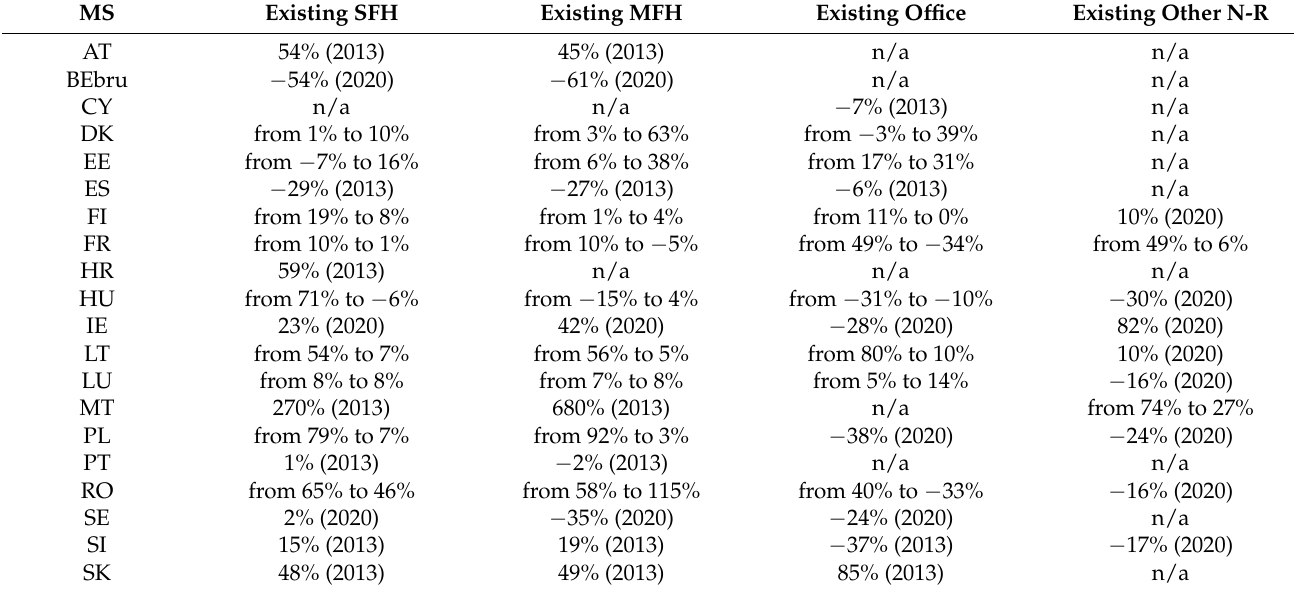
Table 9. Consolidated version of shortfalls against minimum energy performance requirements for existing buildings, with comparison between 2013 and 2020 values when